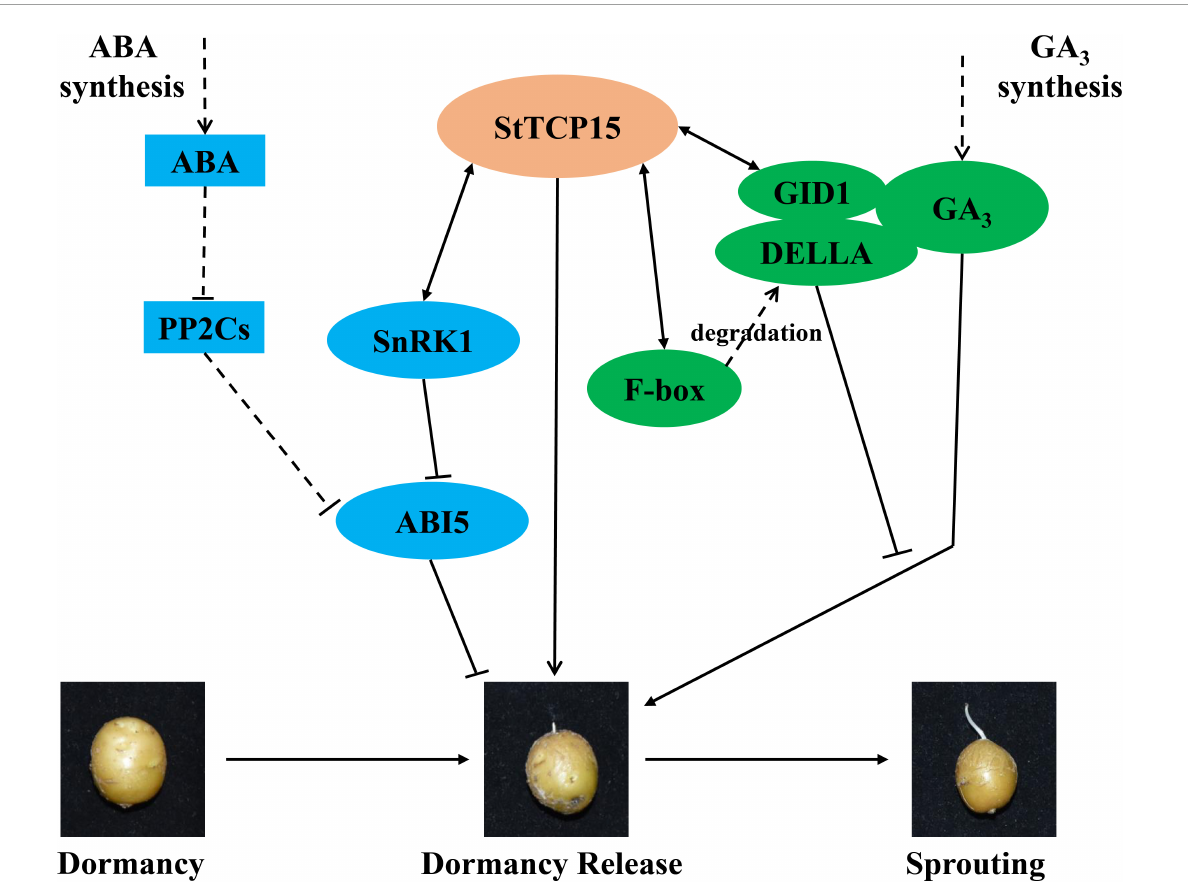
FIGURE7 The putative pathway model of StTCP15 in potato tuber dormancy release. StTCP15 regulates the dormancy and sprouting of potato tubers by regulating the dynamic balance between ABA and GA 3 . GID1 senses GA signals promotes the formation of GID1/GA/DELLA complex, and SLY1 F-Box protein recognizes, binds and degrades DELLA, thus promoting the dormancy release and sprouting of tubers. SnRK1 binds to ABI5, down-regulates the expression of ABI5, participates in ABA signal transduction, and regulates tuber dormancy. Solid lines represent pathways that have been experimentally confirmed to have direct or inhibitory effects, and dashed lines represent pathways that have indirect stimulatory and inhibitory